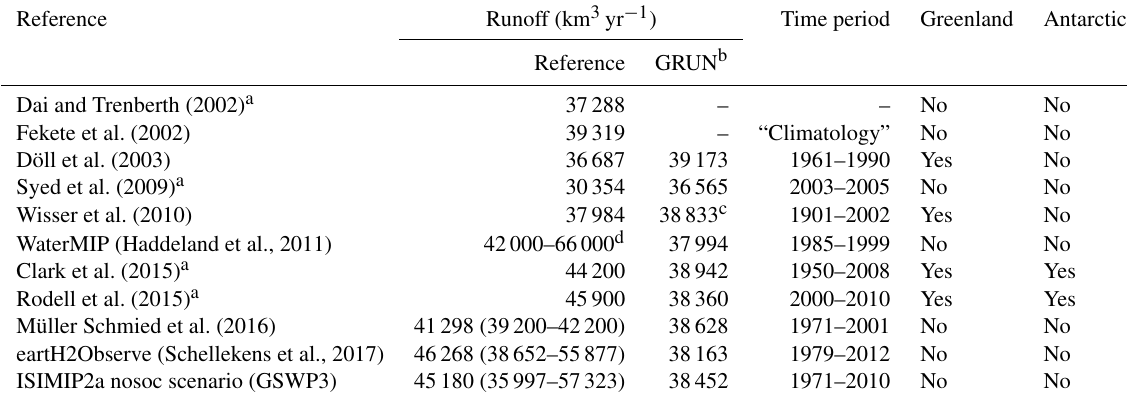
Table 3. Comparing global long-term mean runoff from GRUN against values reported in the literature. GRUN estimates are obtained by considering the same time span and spatial coverage of the reported studies. Values in parentheses denote the uncertainty range reported in some studies.